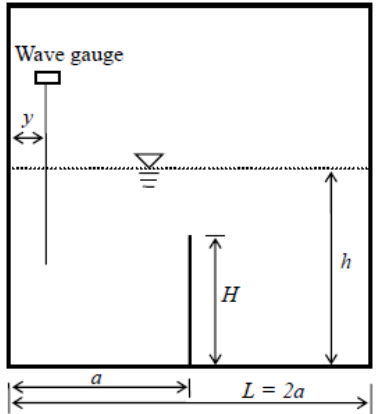
Figure 1. A rectangular tank with a vertical baffle.